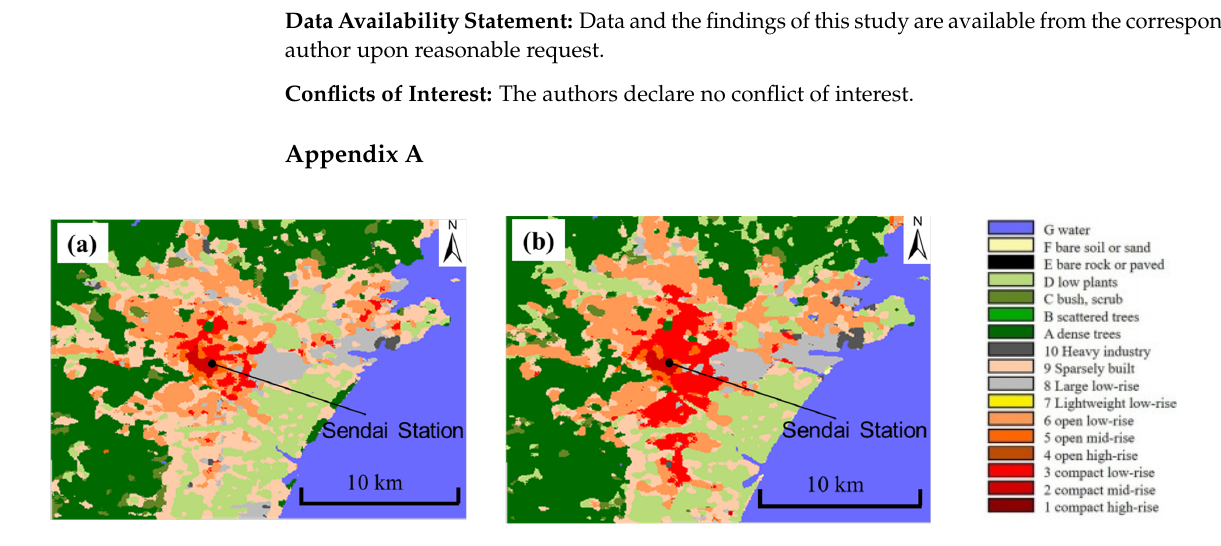
Figure A1. LCZ maps of Sendai with 100 m resolution. ( a ) In 2002; ( b ) in 2022. Table A1. Confusion matrix for the LCZ classification of Sendai, Japan in 2002.